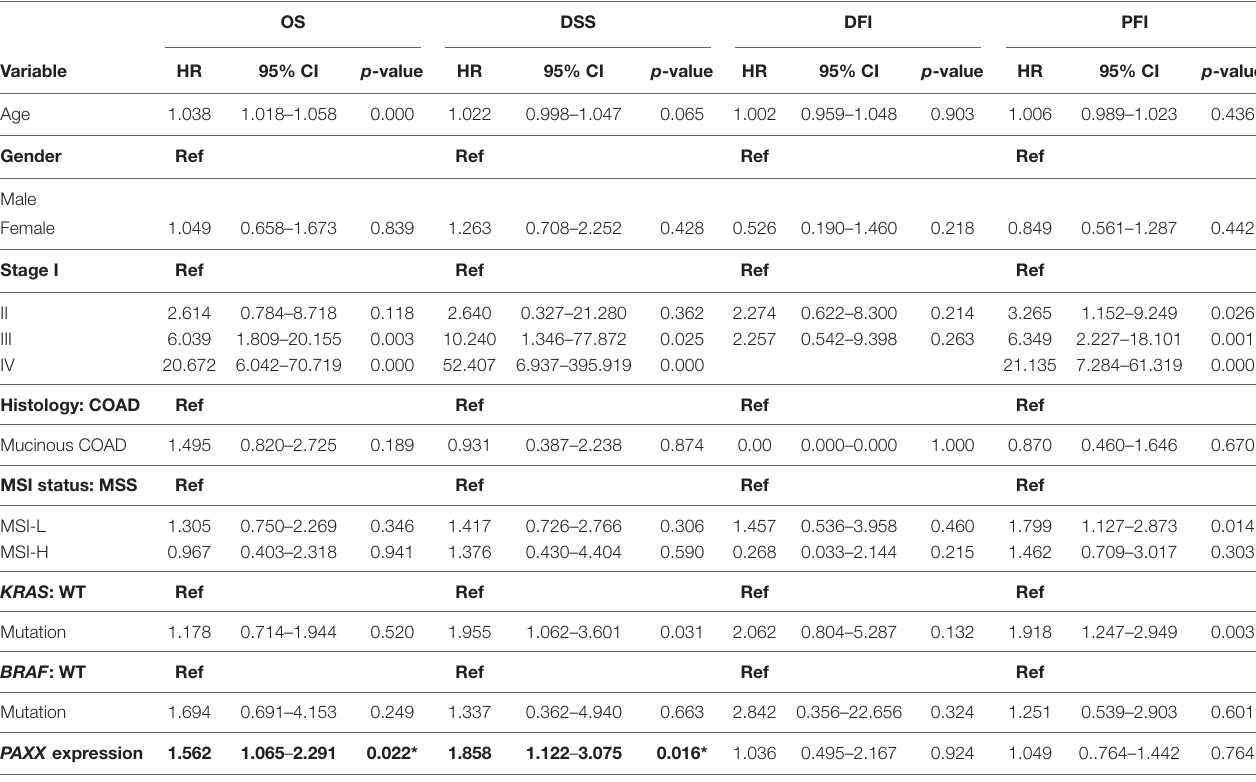
TABLE 3 | Multivariate analysis of PAXX expression and clinicopathological parameters in TCGA-COAD dataset. OS